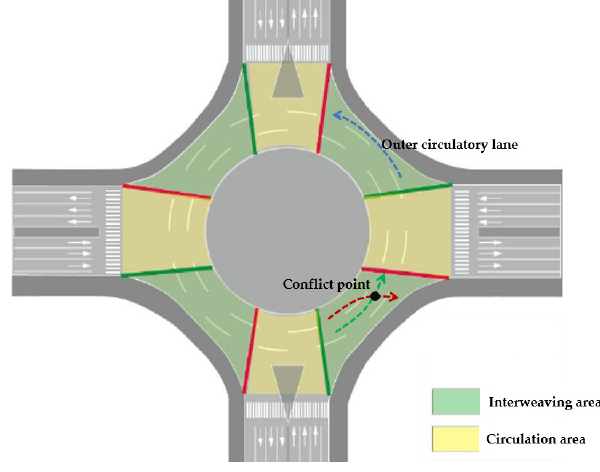
Figure 3. Area division of circulatory lanes in a roundabout.